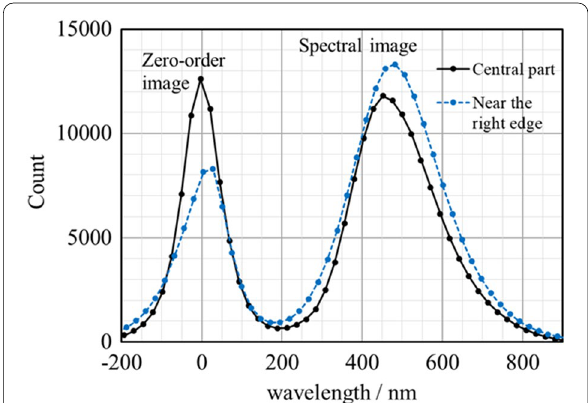
Fig. 12 Count profiles of spectral images of a star, α And (Alpheratz). The solid line profile was obtained for the star images that appeared in the video frames’ central part (No. 5 in Fig. 14). The blue broken line profile was obtained for the images near the edge of the frames (No. 6 in Fig. 14). One hundred frames were averaged for each profile. showed them in the abscissa. The dark frame has been subtracted.